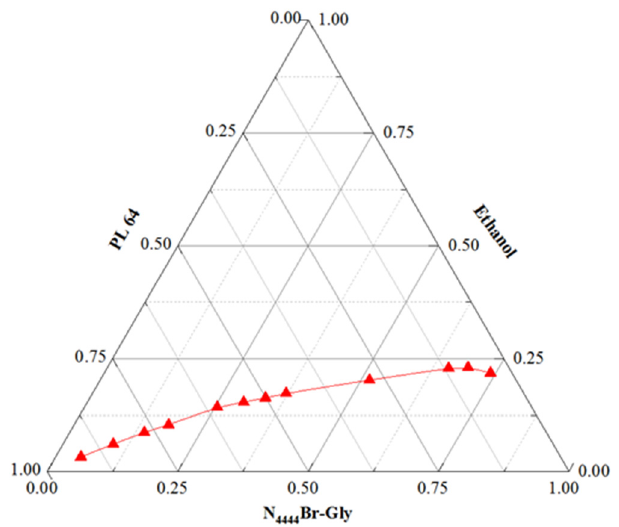
Figure 2. Phase diagram for system composed of N 4444 Br-Gly, PL 64, and ethanol at 25 °C and atmospheric pressure. Compositions are given as weight fractions. Red triangle symbols represent the experiment values.